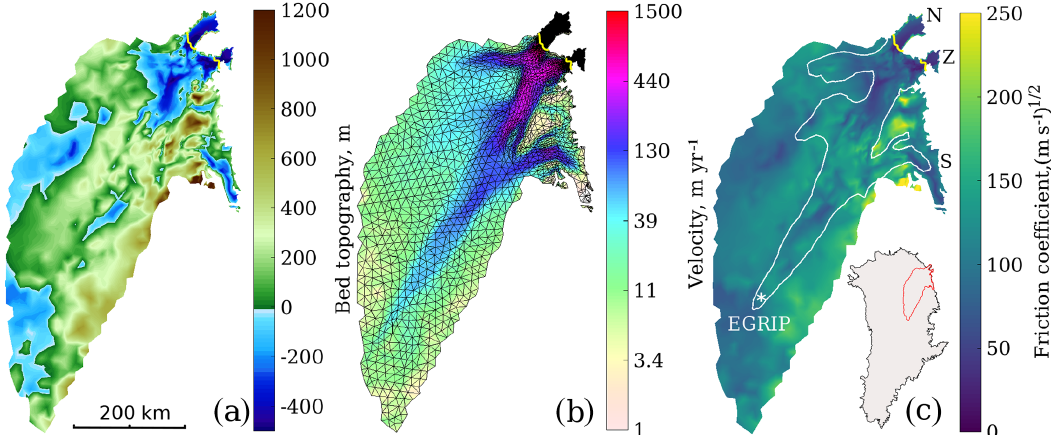
Figure 1. (a) Bed topography from BedMachine (Morlighem et al., 2014) interpolated onto the model mesh; (b) InSAR-derived surface velocities (Rignot and Mouginot, 2012) and anisotropic model mesh refined in areas with high velocity gradients; (c) friction coefficient as a linear function of bed topography (Eq. 3) used in Eq. (1). The white contour shows the area of the NEGIS with observed surface velocity of 50myr − 1 and the star shows the position of the East Greenland Ice-Core Project (EGRIP). N, Z and S indicate the outlets of the ice stream: 79N, Zachariæ and Storstrømmen, respectively. The yellow line in all panels represents the grounding line, and the inset map in the lower right corner shows Greenland with the model domain outlined in red. Table 2. Mantle plume parameter overview for the plume experiments. Parameter Description Value Unit Mantleconductivity mantle heat conductivity Wm − 3 Nusselt Nusselt number, ratio of mantle to plume 500000 Dtbg background temperature gradient Plumeradius radius of the mantle plume varying m Topplumedepth depth of the mantle plume top below the crust 5000 m Bottomplumedepth depth of the mantle plume base below the crust varying km